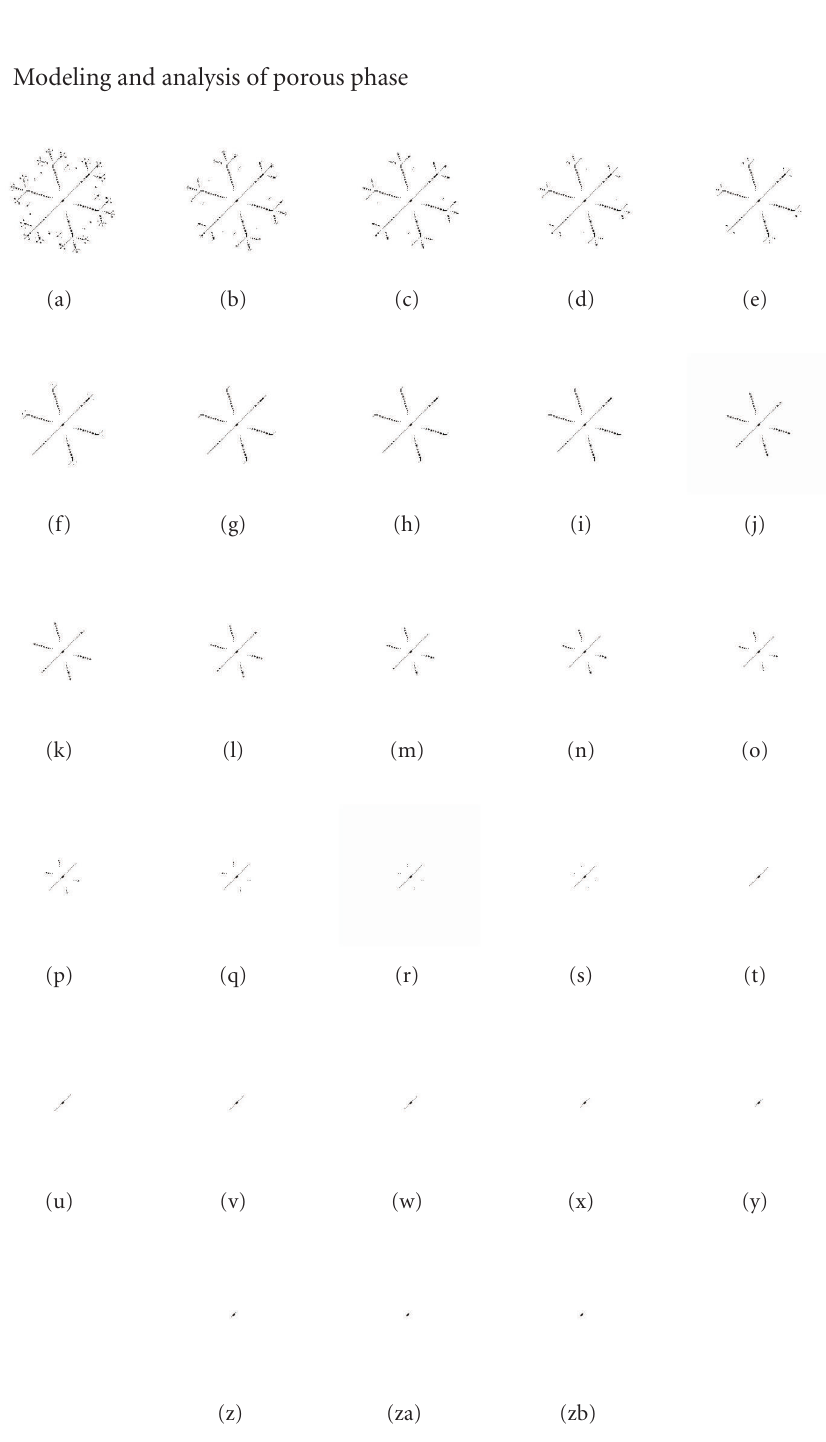
Figure 3.2. Pore-channel network from eroded versions of fractal